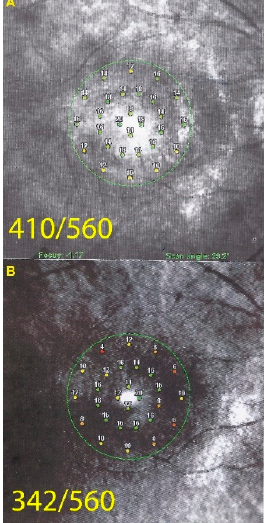
Figure 4. Microperimetry OD in patient 1 with AZOOR at presentation ( A ) and after 6 years of follow-up ( B ). Decrease of microperimetry score especially among the peripheral measurement points after 6 years of evolution indicating slow progression of the process. Multimodal imaging findings remained stable in the left eye. On the right side, the peripheral fundus took the aspect of a pseudo retinitis pigmentosa with pigment clumps (Figure 5).